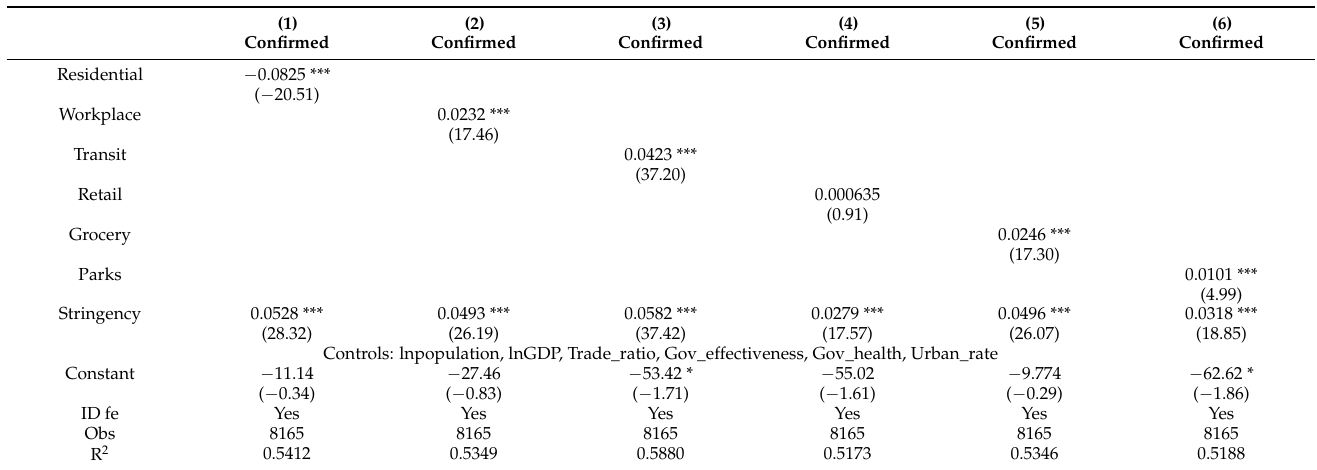
Table 2. Impact of Google mobility on the number of new confirmations.